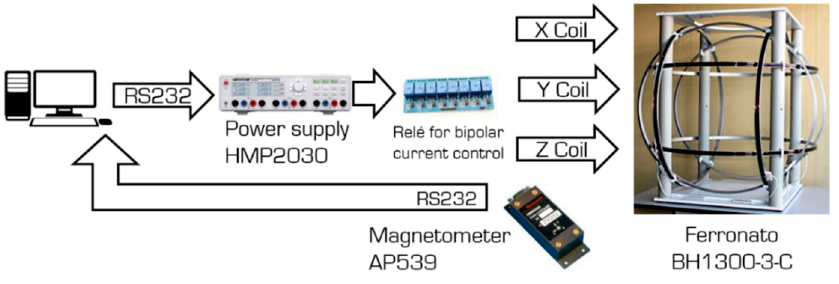
Figure 2. Architectural diagram of the closed-loop magnetic field control system for the Helmholtz cage.